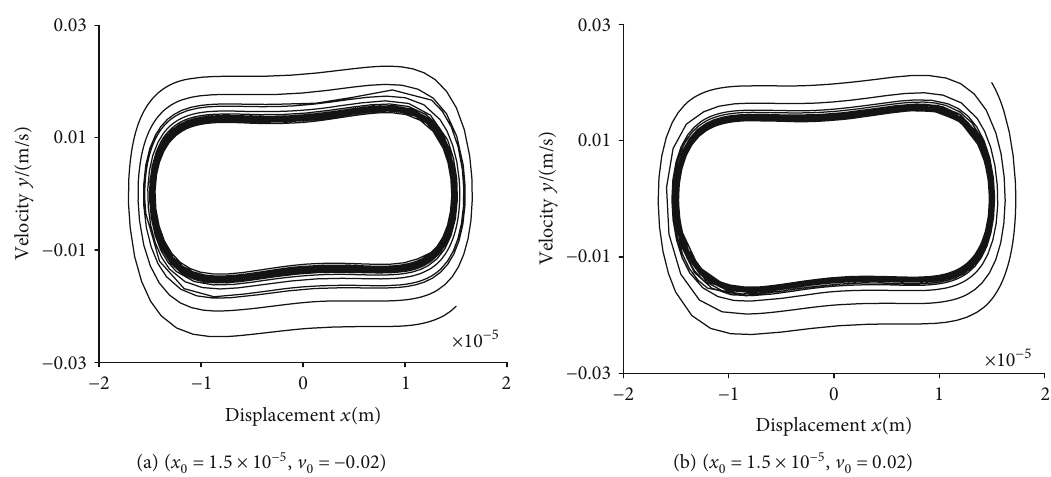
= 1 : 8A , q = 1 : 2 × 10 − 4 m 3 /s . 0 0